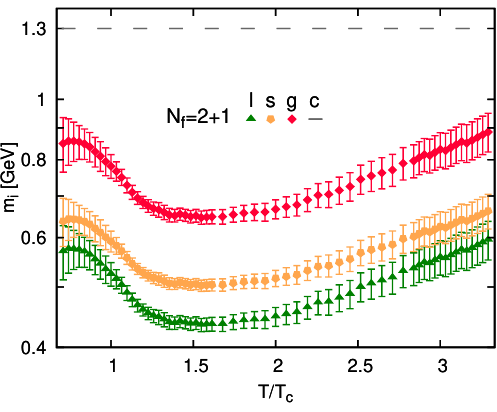
Figure 1. Masses of the QGP constituents as functions of the temperature scaled by the pseudocritical T c = 0 . 155